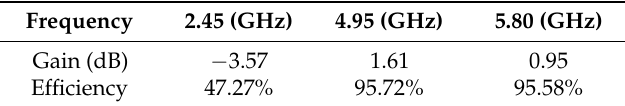
Table 4. Gain and efficiency of the proposed antenna.